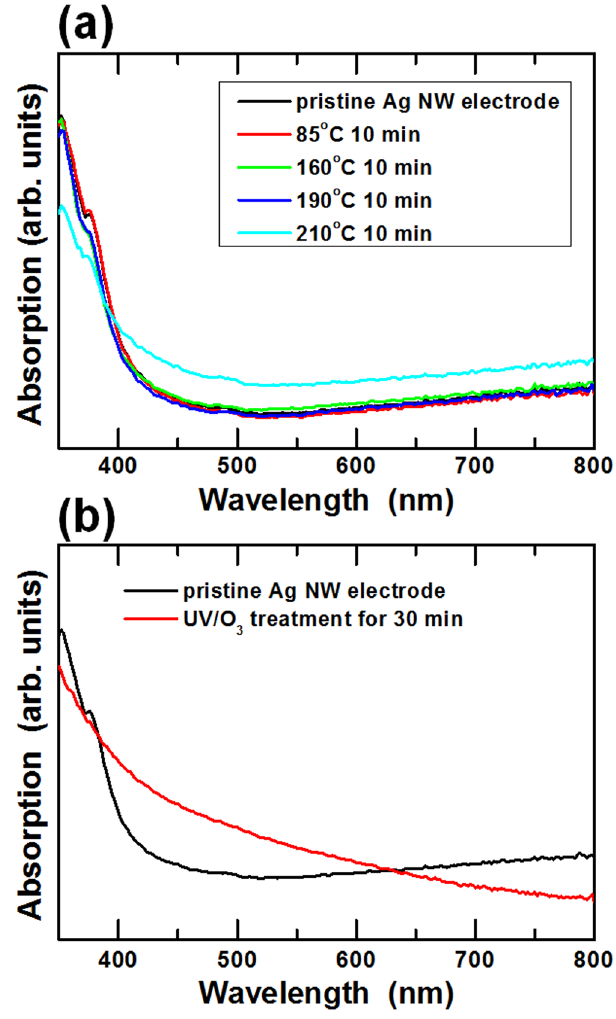
Figure 2. Absorption spectra of the Ag NW electrodes for ( a ) a 10-min thermal treatment at various temperatures and for ( b ) a 30-min UV/O 3